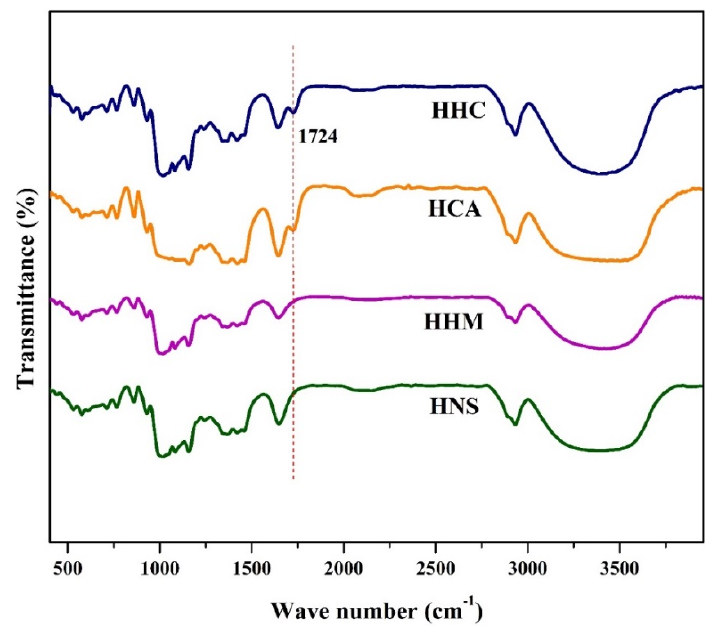
Figure 2. FT-IR spectra of native and modified Hausa potato starches.